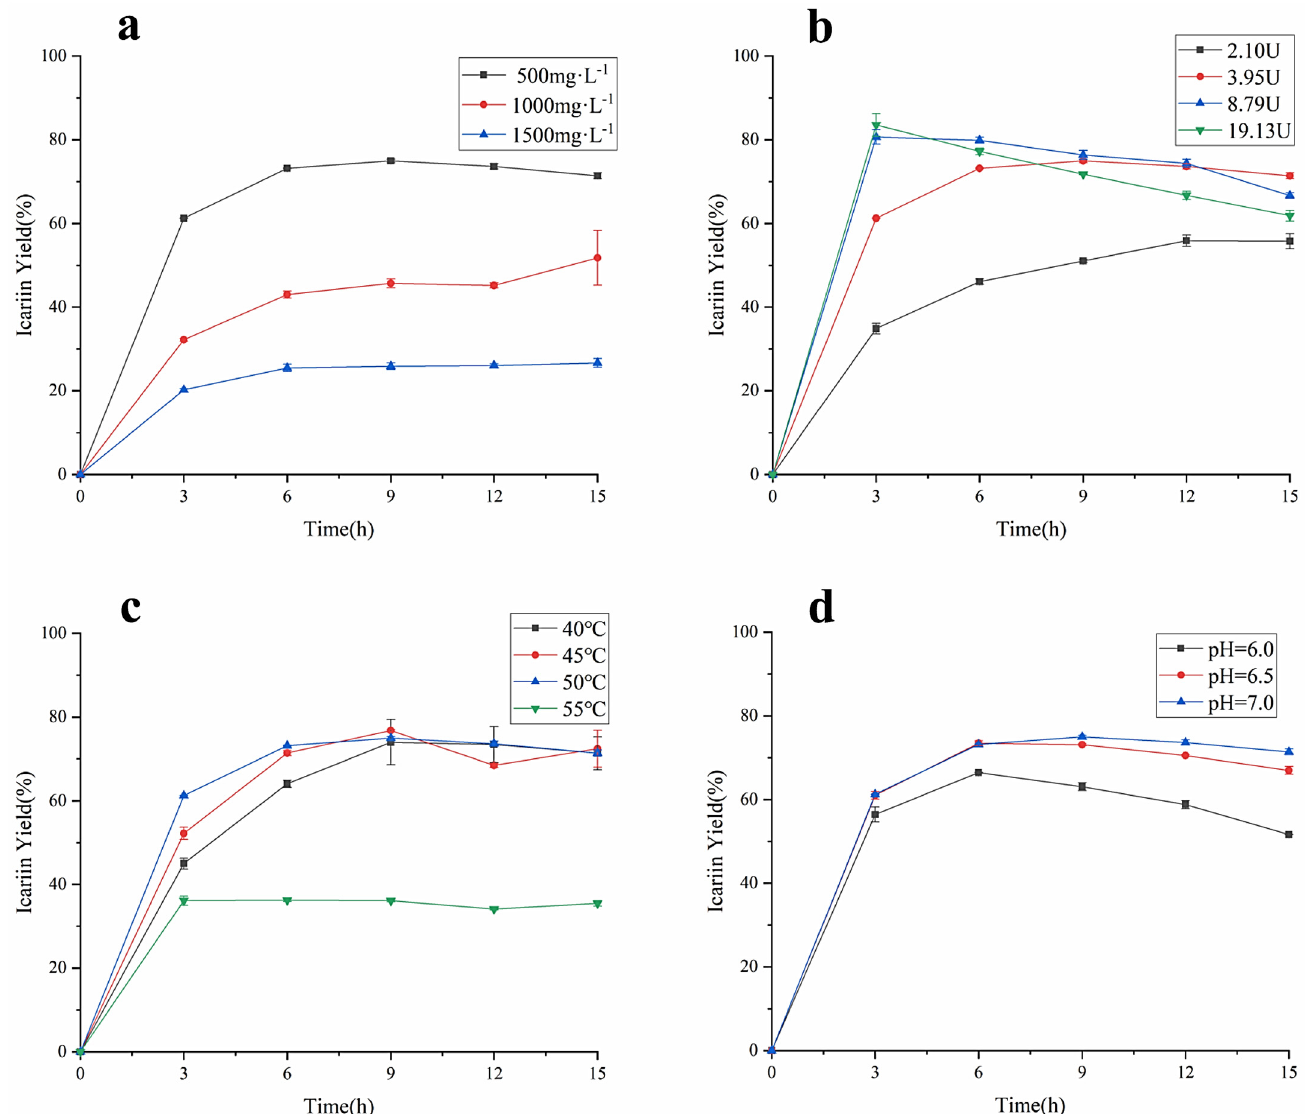
Figure 5. ( a ) The amount of α -L-rhamnosidase on icariin yield at 50 °C under pH 4.0 with 3.95 U of enzyme. ( b ) The amount of α -L-rhamnosidase on icariin yield at 50 °C under pH 4.0 with 500 mg · L − 1 epimedin C. ( c ) Temperature influence with 3.95 U of enzyme in the reaction system containing 500 mg · L − 1 epimedin C at pH 7.0. ( d ) pH influence with 3.95 U of enzyme in the reaction system containing 500 mg · L − 1 epimedin C at 50 ◦